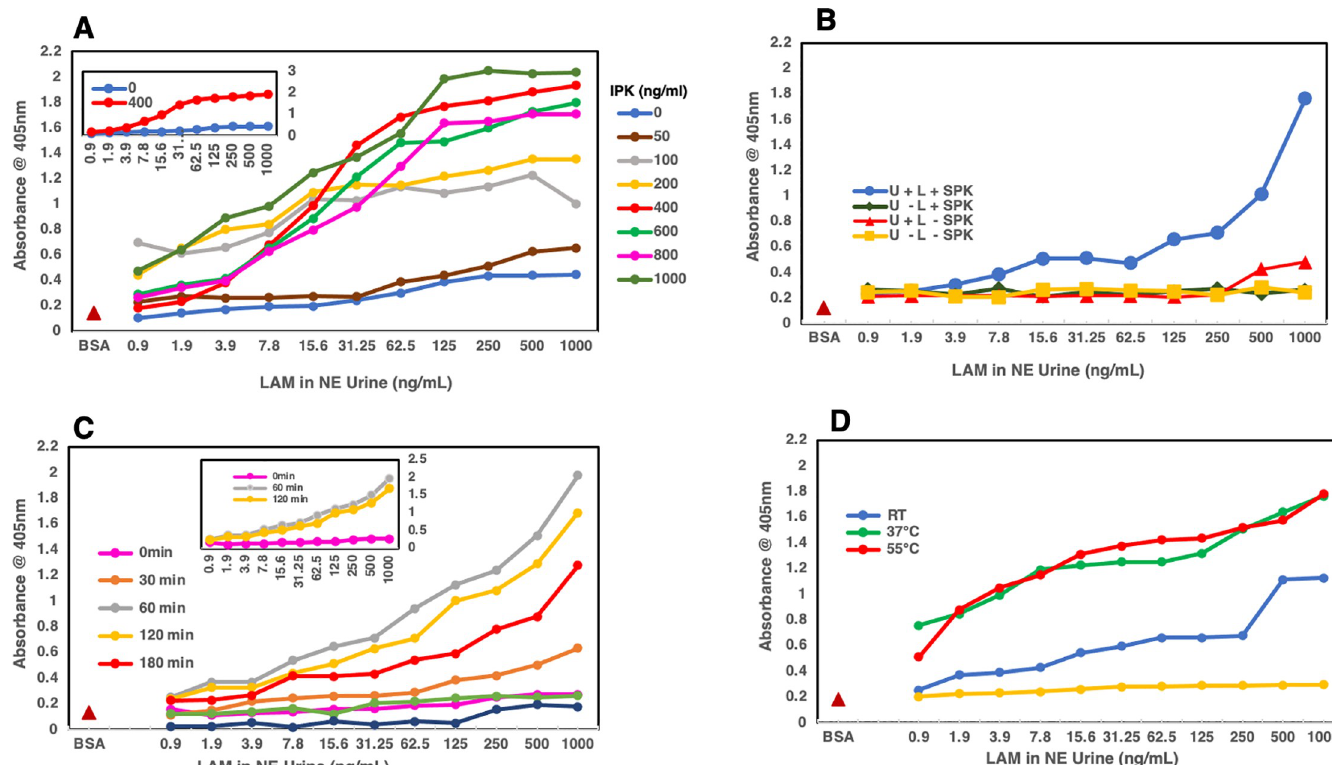
Fig 4. Indirect ELISA. A) Shows the concentration curve (0–1000 μ g /mL) for IPK that would give optimal results when used for the pretreatment of urine spiked with LAM. The inset shows 400 μ g /mL of IPK (red) to be the optimal concentration that gives the best results compared to the urine spiked with LAM that did not see any IPK (dark blue). B) Showing the standard Proteinase K (SPK) treatment of urine from a healthy volunteer spiked with LAM purified from M . tb CDC1551 cells. The blue line with circles shows the effect of SPK in sequestering LAM from the protein/s or other inhibitors present in urine compared to the red line with triangles where the urine spiked with LAM has not been pretreated with SPK. The yellow line shows the background signal obtained with the urine and the green line with diamonds shows that Proteinase K itself does not have any effect on blank urine. C) Shows the optimal time required for the pretreatment, with IPK at 400 μ g /mL, of urine spiked with LAM. At 60 min (grey line) and 120 min (yellow line) (see inset) compared to the 0 min (pink line) pretreatment time, more LAM seems to be available for binding to the antibody. D) Shows the optimal temperature needed (55˚C) for the IPK pretreatment of urine spiked with LAM for 60 min at 400 μ g/mL of